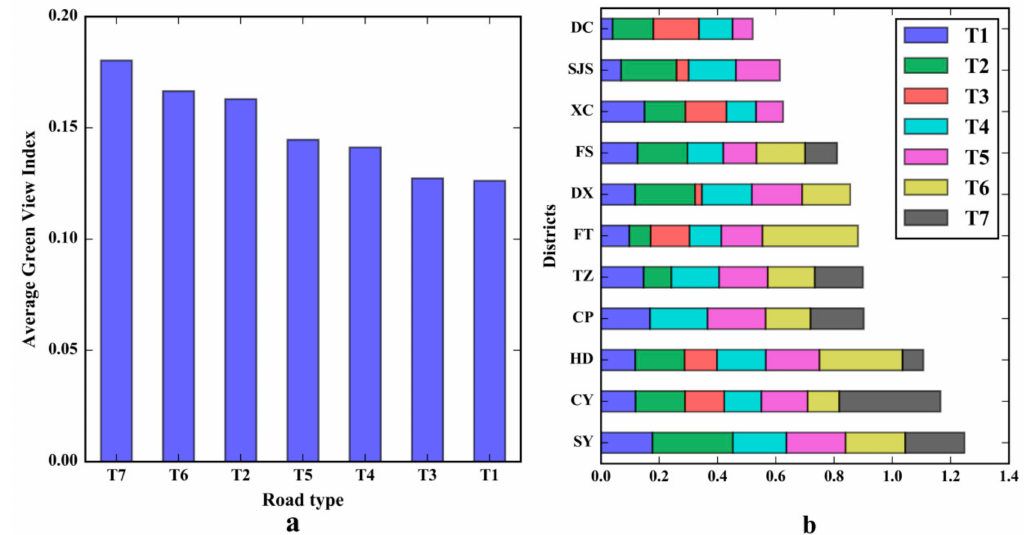
Figure 10. The statistical green view index (GVI) values of different road types. Subplot ( a ) shows a bar plot of the average GVI values in different road types. Subplot ( b ) shows the cumulative sum of the average GVI values in different road types.